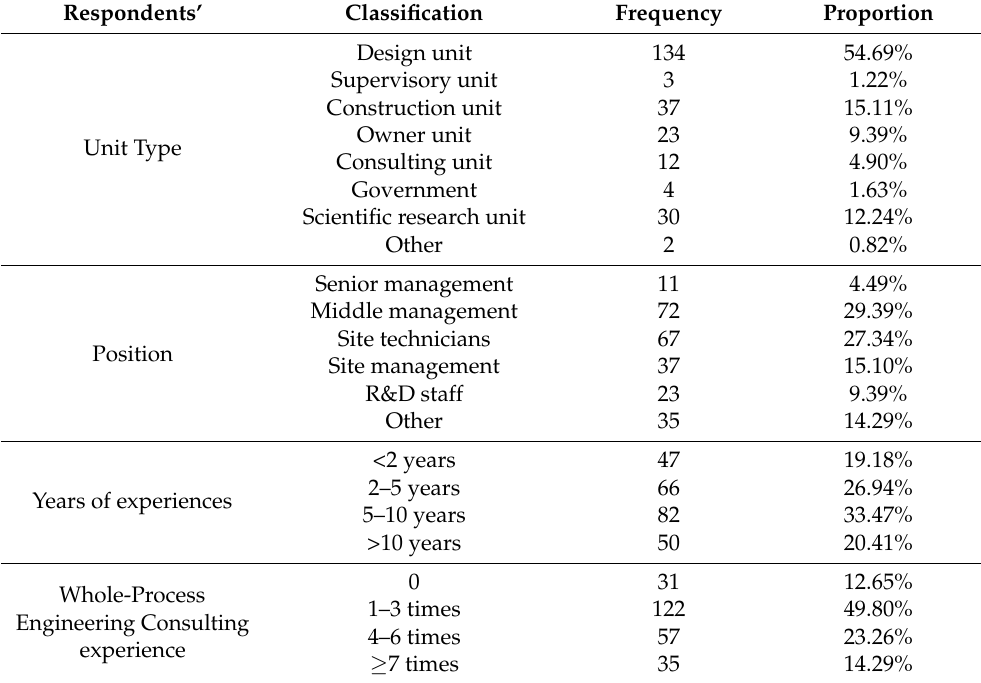
Table 1. Profiles of respondents and